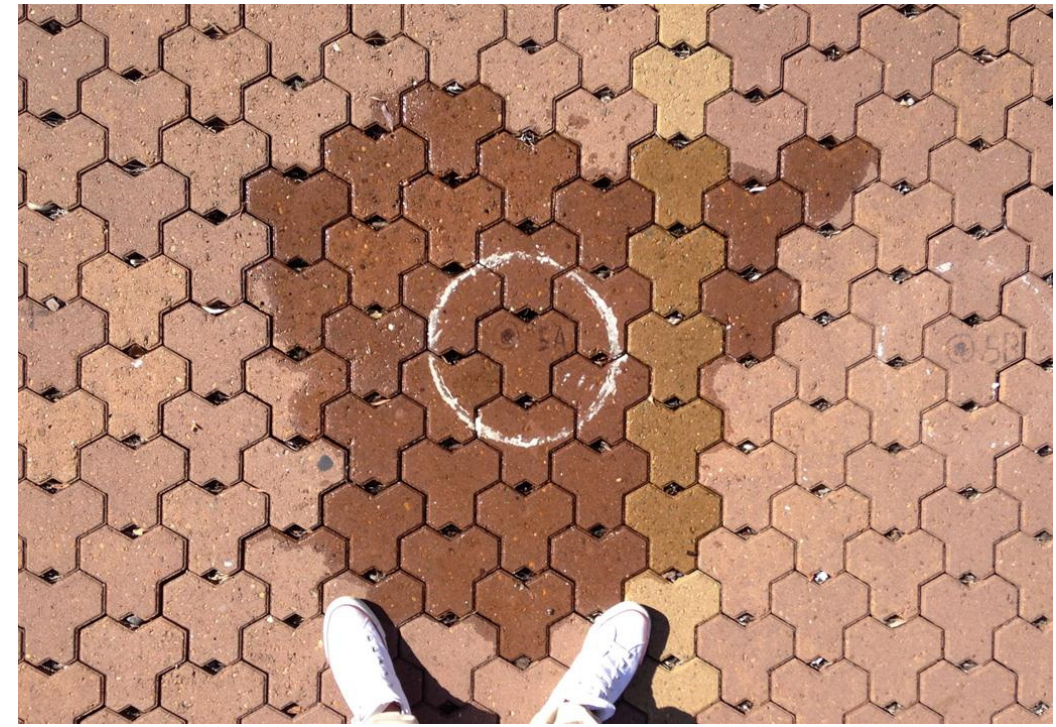
Figure 6. Photograph showing SWIFT water stain (30 Fully-wetted bricks) over the precise location previously tested using the SRIT